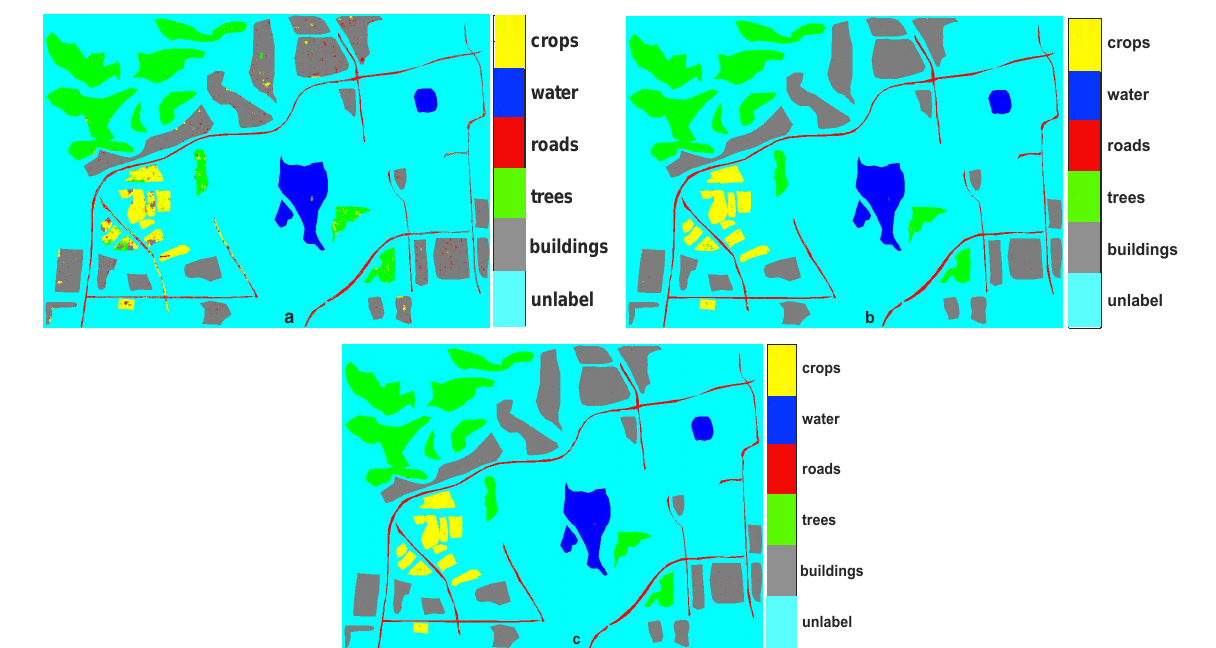
Figure 11. Classification map for labeled areas by three models with all band features: ( a ) SVM; ( b ) conventional RF; ( c ) RF with Bayesian optimization.